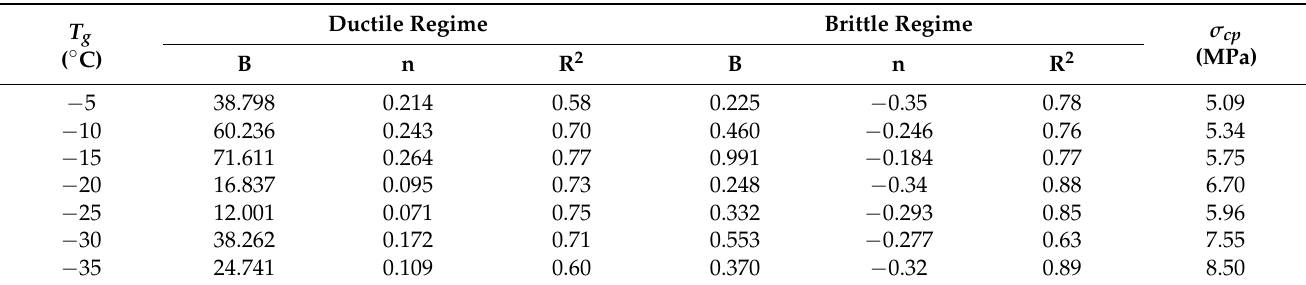
Table 3. The fitting coefficients and coefficients of determination R 2 of uniaxial compressive strength tests on distilled water ice.